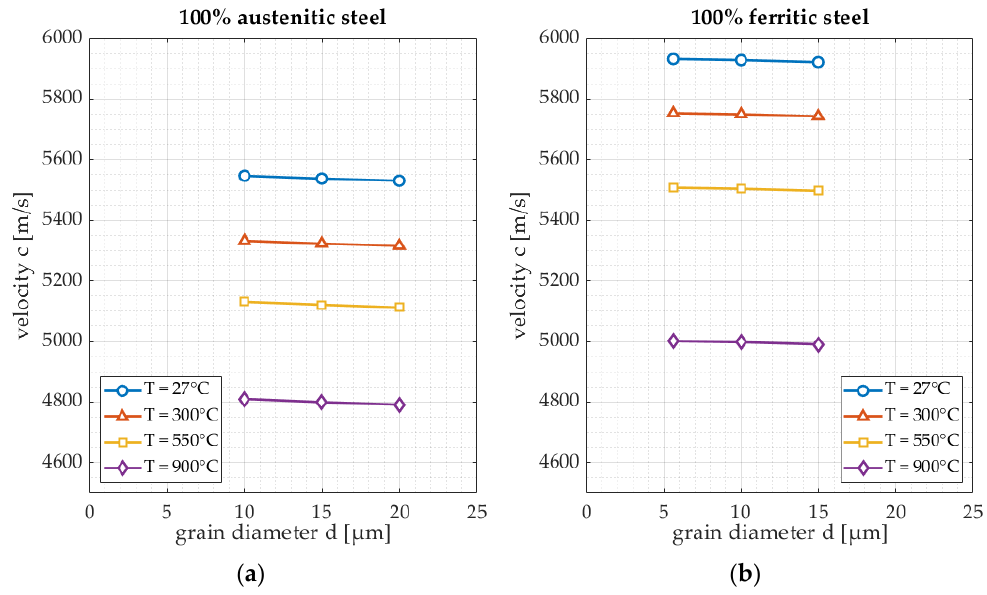
Figure 12. The relation between the grain diameter d , and observed wave velocity c for two material types and four temperatures: ( a ) shows 100% austenitic steel; and ( b ) 100% ferritic steel.